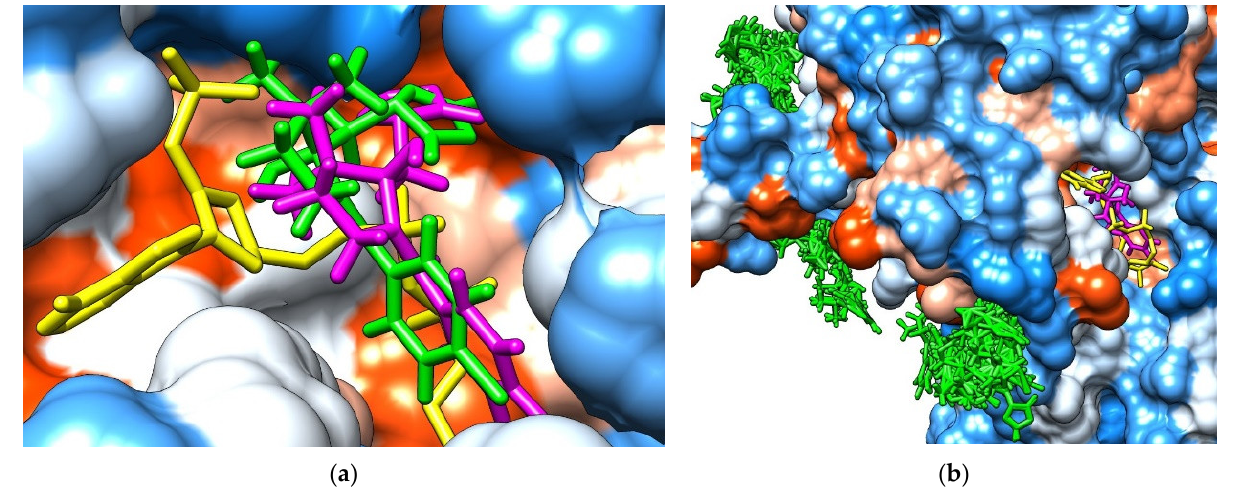
Figure 7. The binding modes corresponding to the highest interaction energies recorded for the binding of the (R)-TTZ and (S)-TTZ to the Clostridium beijerinckii NADP-dependent alcohol dehy- drogenase ( a ) and the aldehyde dehydrogenase from Bacillus cereus ( b ). The proteins are shown as hydrophobicity surface (blue regions are hydrophilic, orange regions are hydrophobic) the NADPH is shown as yellow sticks, (R)-TTZ as magenta sticks, and (S)-TTZ as green sticks.